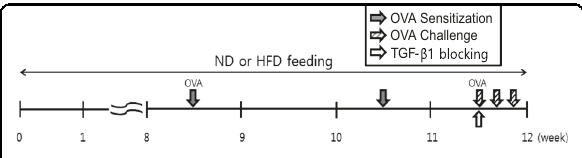
Fig. 1 Study scheme. ND normal diet, HFD high-fat-diet, OVA